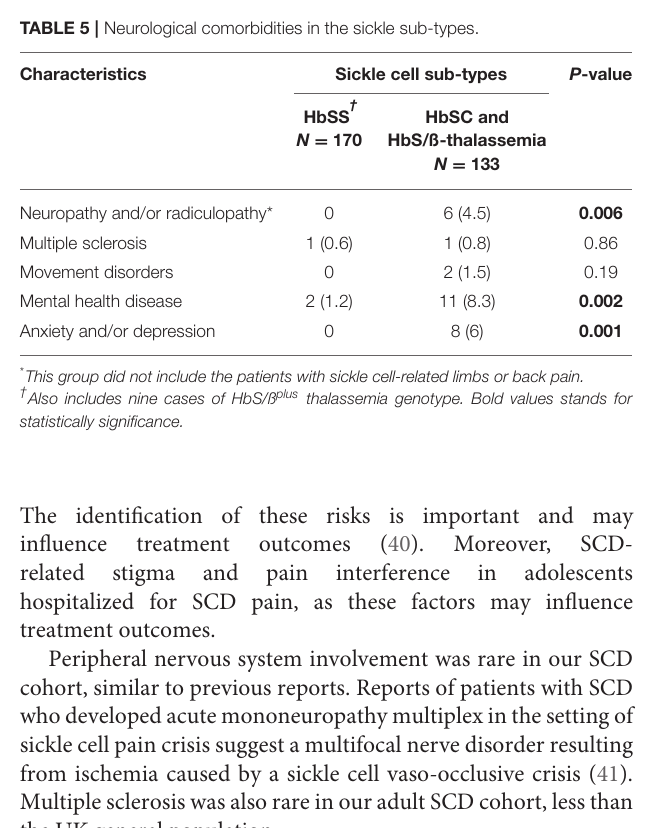
TABLE 4 | Stroke prevention in sickle cell disease. Characteristics